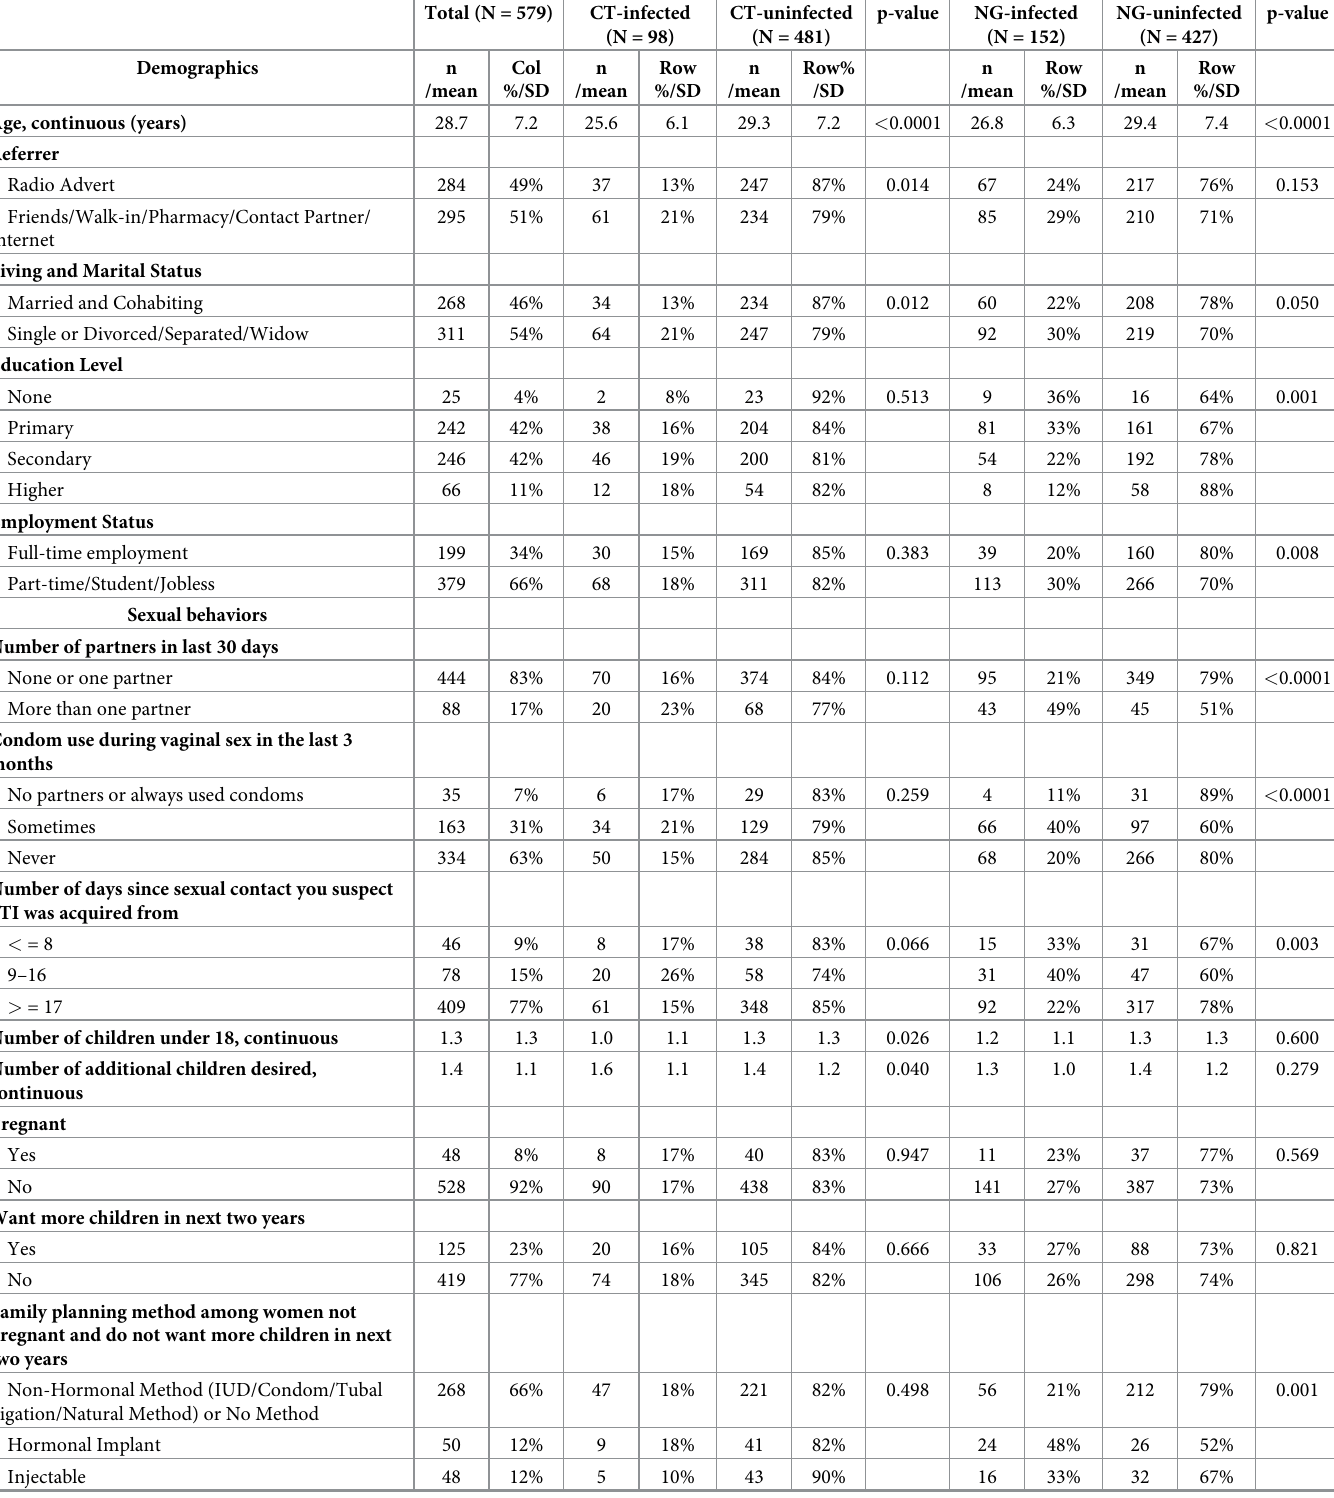
Table 4. Factors associated with CT or NG infection in women in Kigali, Rwanda (N =